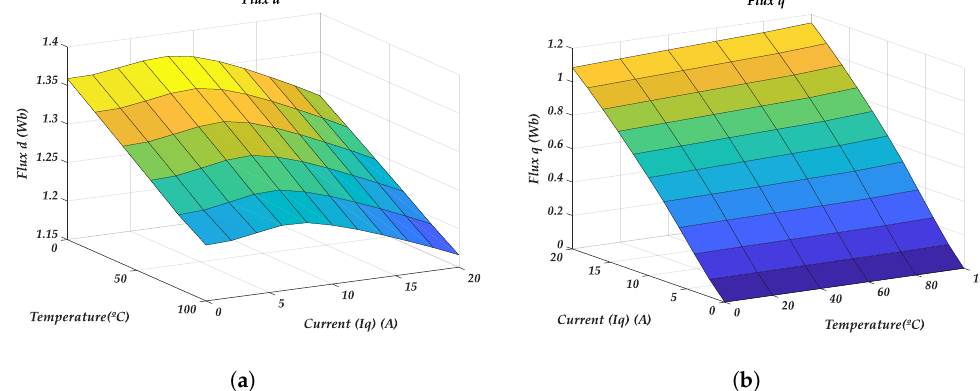
Figure 10. Generated magnetic flux maps: magnetic flux vs. Current and Temperature for the Qs36p15 motor. ( a ) D magnetic flux map; ( b ) Q magnetic flux